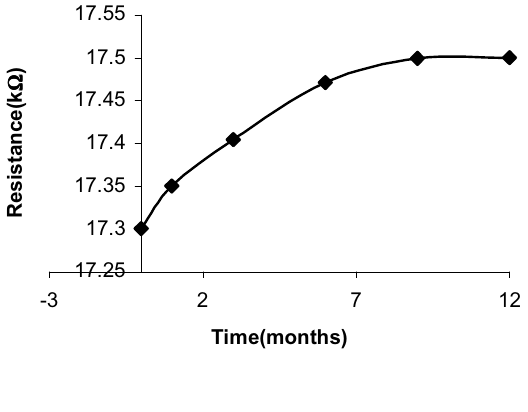
Figure 6. Drift of Sample